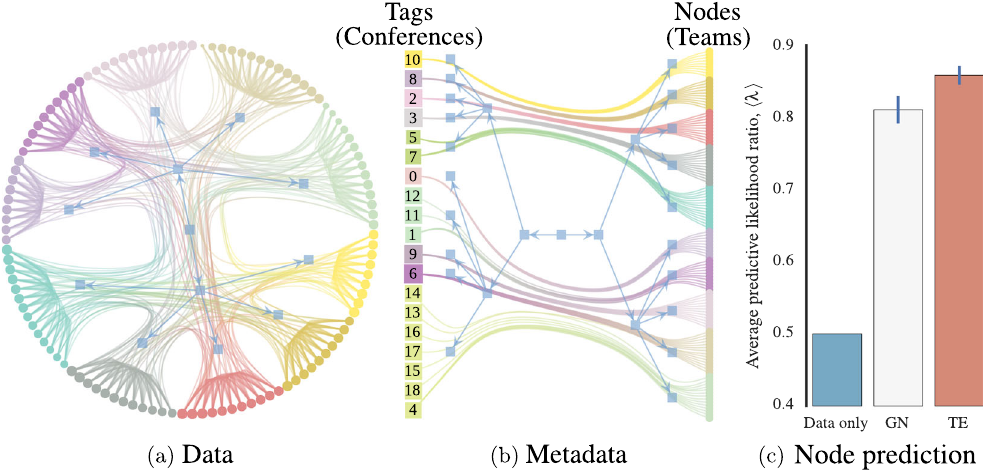
FIG. 2. Joint data-metadata model inferred for the network of American football teams [45]. (a) Hierarchical partition of the data nodes (teams), corresponding to the “ data ” layer. (b) Partition of the data (teams) and tag (conference) nodes, corresponding to the second layer. (c) Average predictive likelihood of missing nodes relative to using only the data (discarding the conferences), using the original conference assignment of Ref. [45] (GN) and the corrected assignment of Ref. [46]